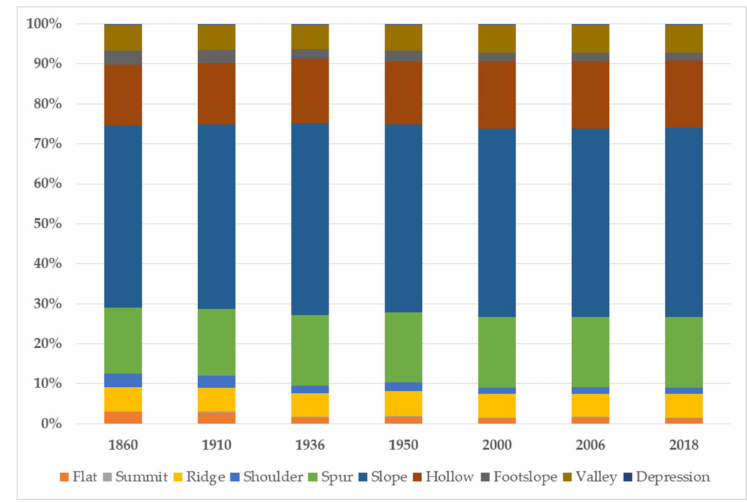
Figure 8. Frequency distribution histograms (%) for each geomorphology class. Concerning exposure, there is no predominant orientation for each year